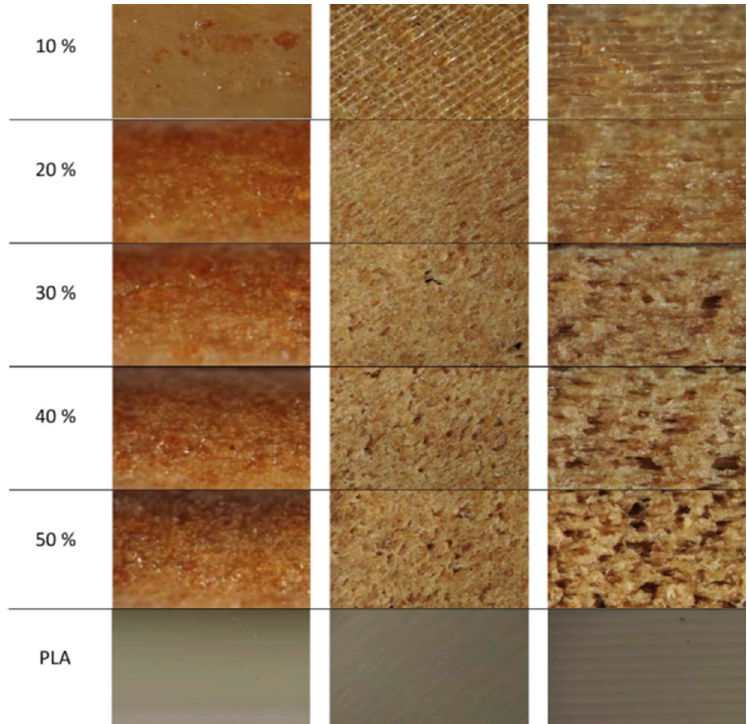
Figure 3. Challenges with filament production including voids, pores, and uneven distribution of filler. Cross-sectional optical micrographs displaying the appearance of filament ( left ), surface ( middle ) and edge ( right ) of the 3D printed part. Reprinted from [38] with permission from Elsevier. Copyright (2018).